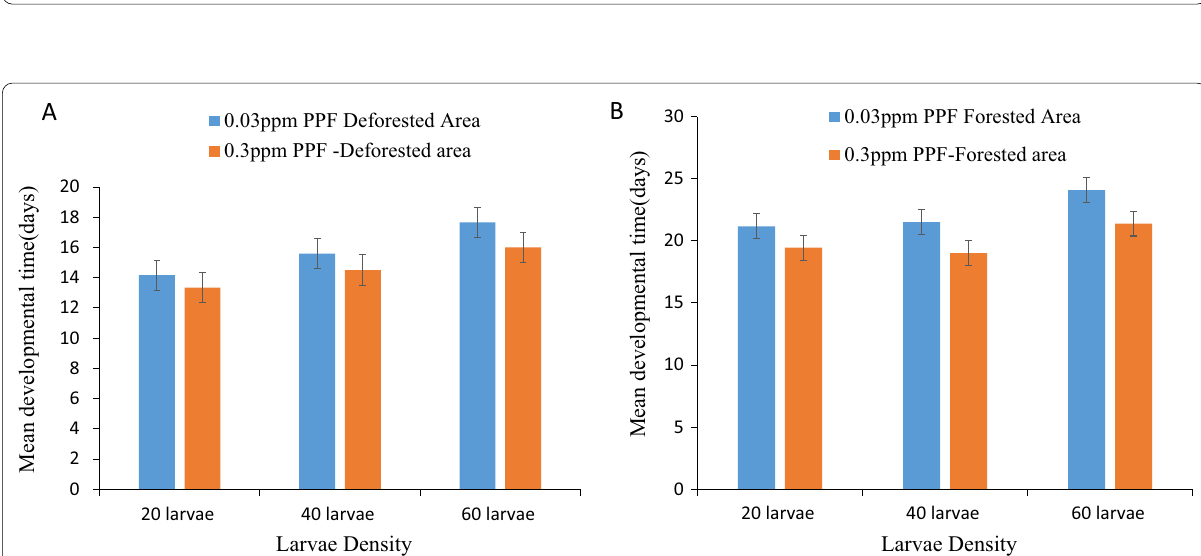
Fig. 4 The impact of pyriproxyfen at 0.03 ppm on An. gambiae s.s. development time between forested and deforested area A – C and the comparison of larvae development in control D (experiments repeated 6 times in 3 rounds)